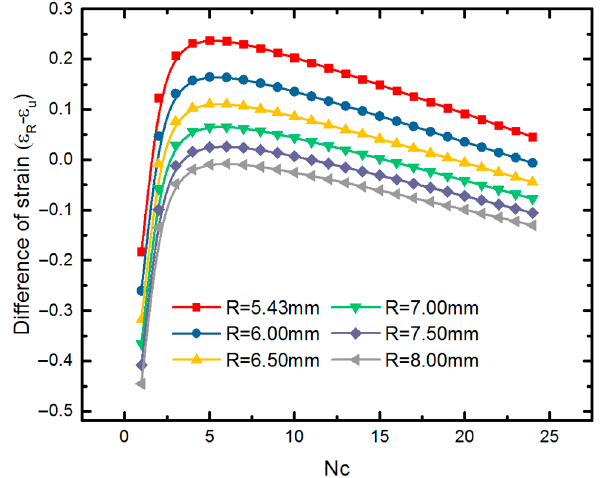
Figure 19. Di ff erence of required strain and ultimate strain of SMP stent with di ff erent radii at the same Figure 19. Difference of required strain and ultimate strain of SMP stent with different radii at the programmed same programmed radius.